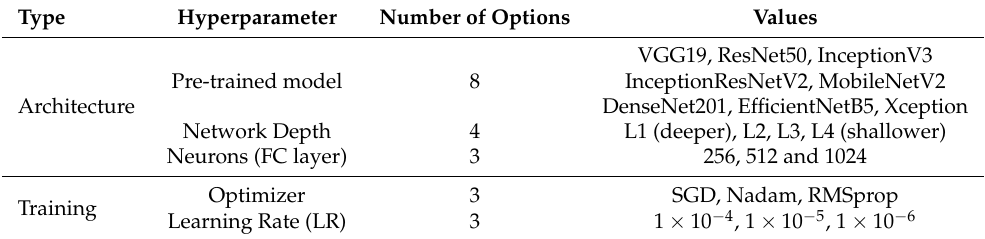
Table 4. Stage 2: Hyperparameters and values selected in this